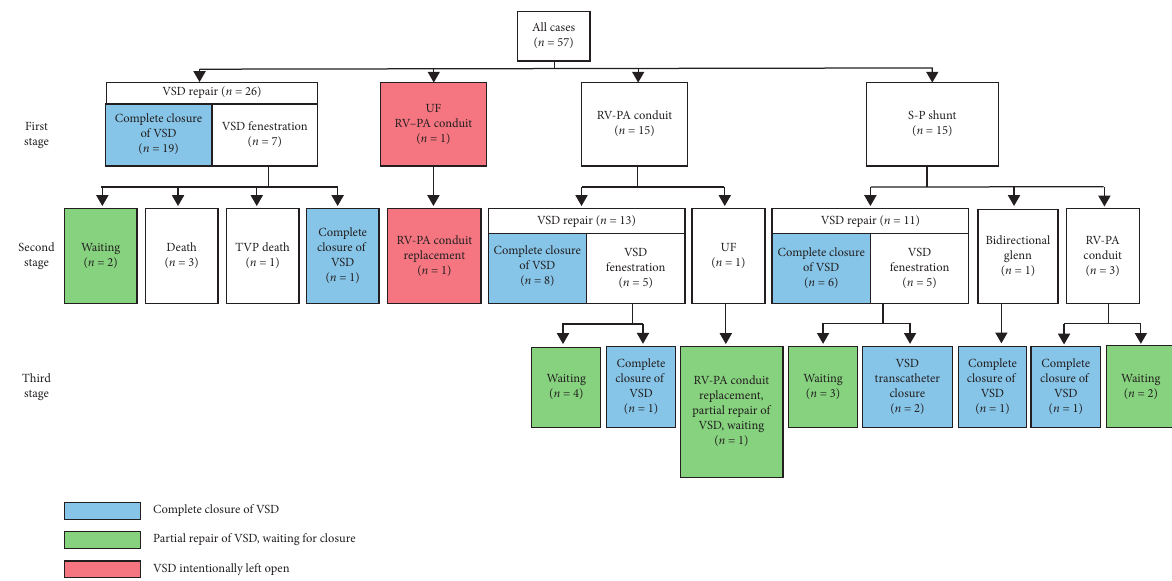
Figure 1: Surgical process for the whole group of subjects with PA/VSD/MAPCAs (RV-PA: right ventricle-pulmonary artery; TVP: tricuspid valvuloplasty; UF: pulmonary artery unifocalization; VSD: ventricular septal defect). Table 1: Cause of